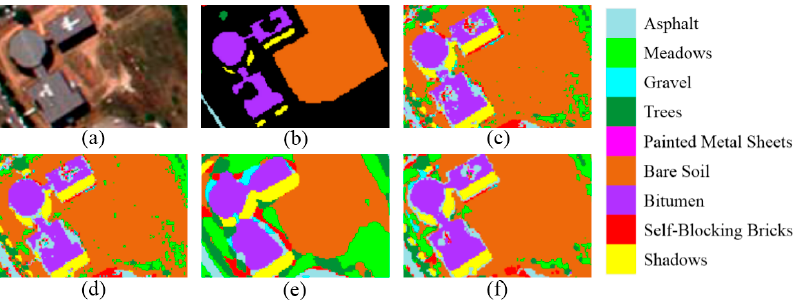
Figure 8. Zoom of classified region. ( a ) False-color composite. ( b ) Ground truth. ( c ) SAE-LR, OA = 98.46%. ( d ) DBN-LR, OA = 98.99%. ( e ) 2D-CNN, OA = 99.03%. ( f ) 3D-CNN, OA = 99.39%.